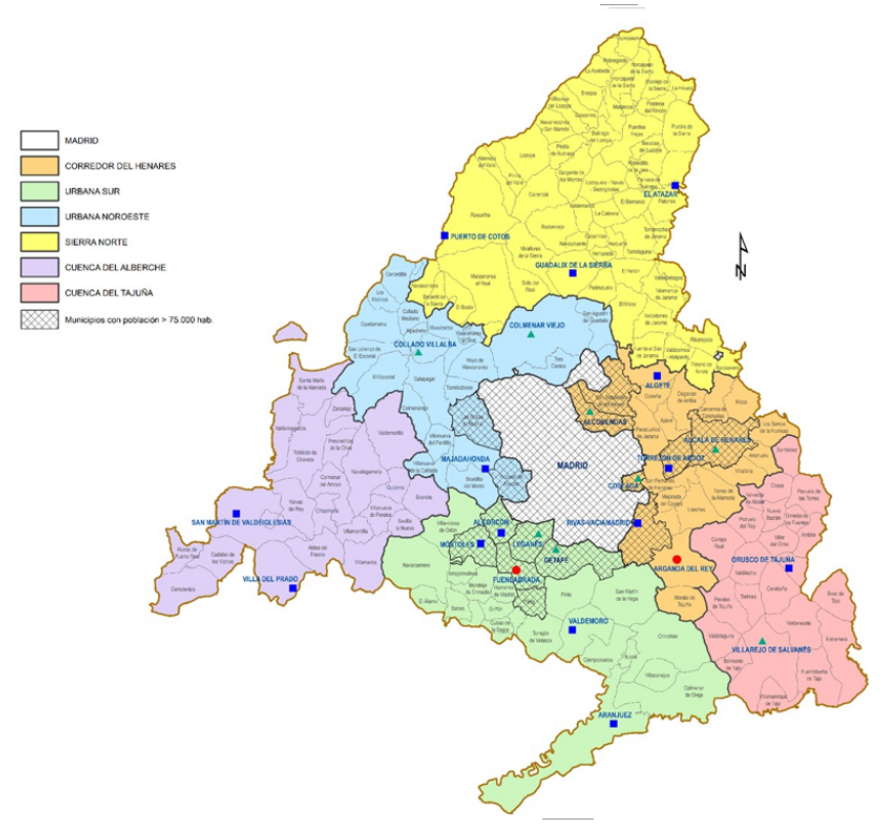
Figure 1. Municipalities, Statistical zones and Location of the NO x MS operating in the Autonomous Community of Madrid in the period 2000–2009. Green Triangle: Traffic stations; Red circle: Industrial stations; Blue square: Background stations.